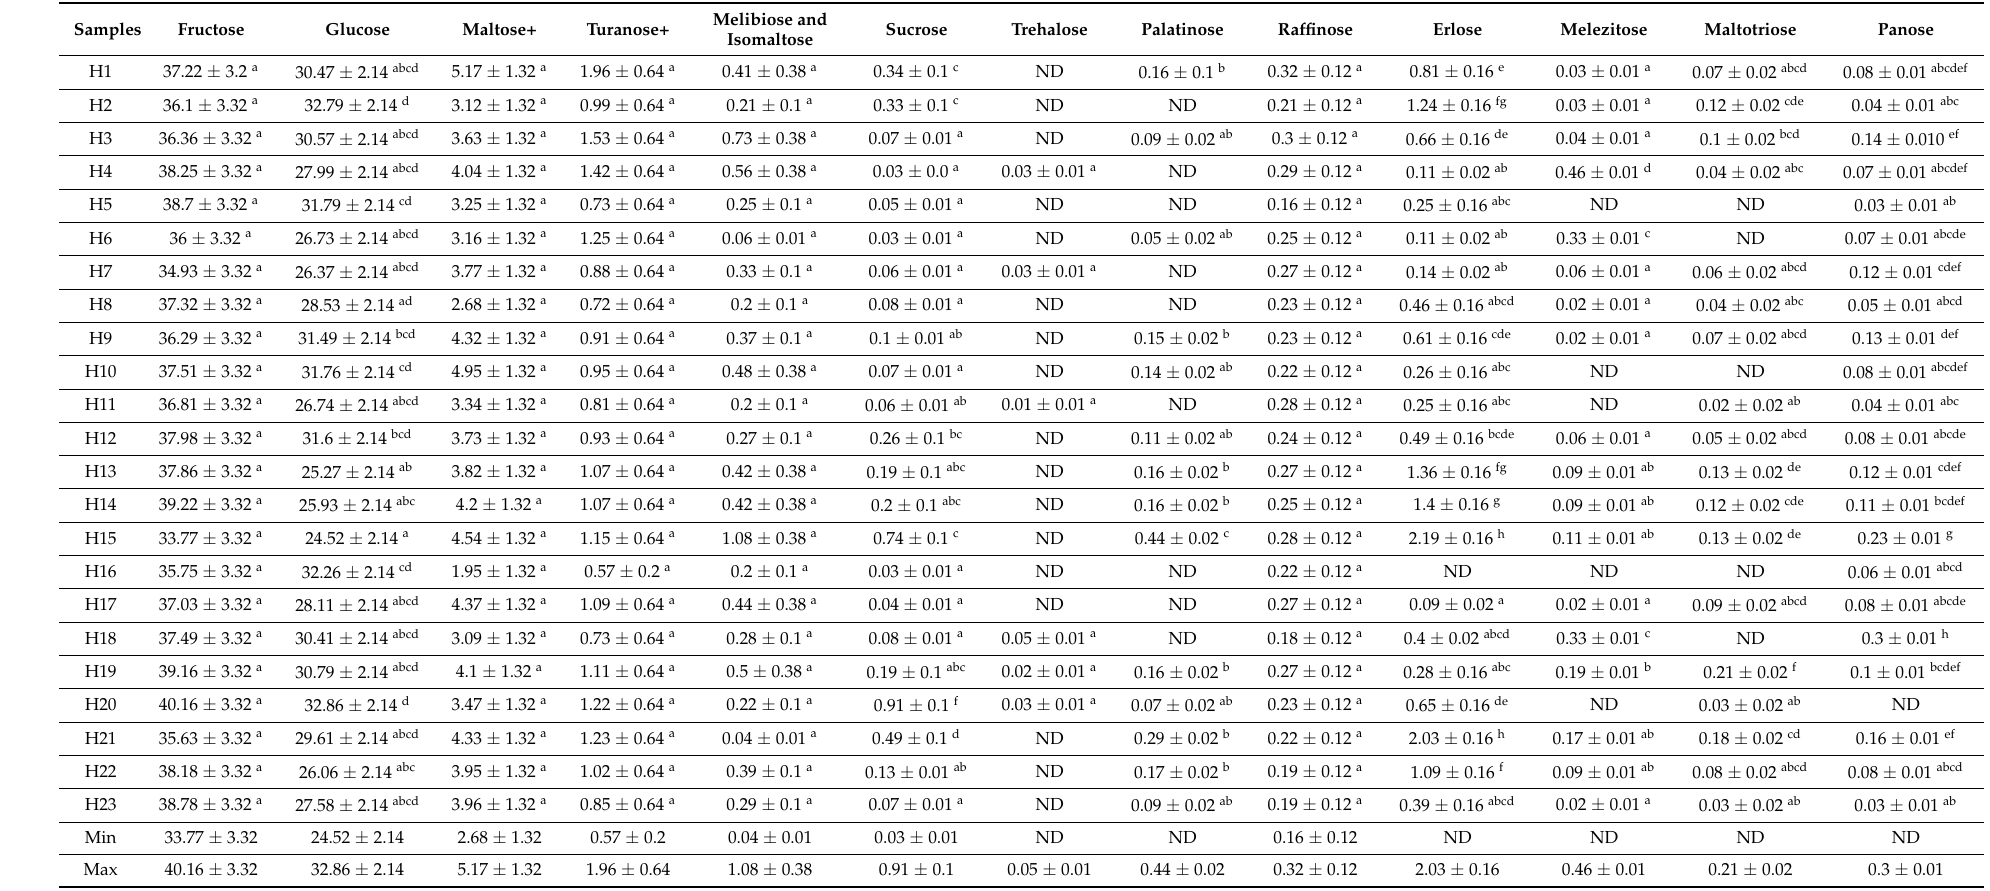
Table 6. Sugars values (g/100 g) of honey